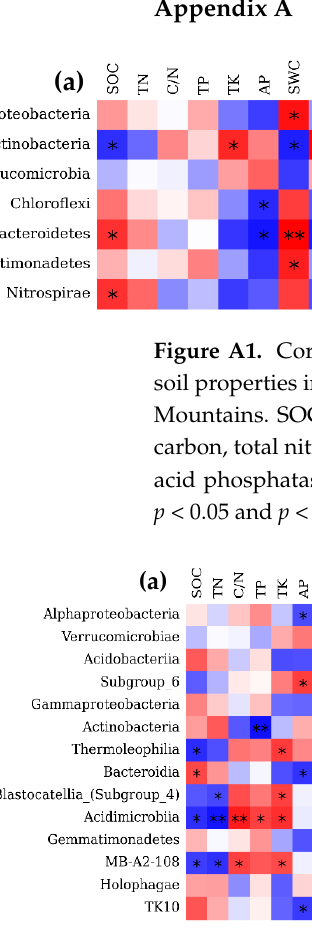
Figure A2. Correlation analysis between bacterial ( a ) and fungal ( b ) class communities and soil properties in broad-leaved Korean pine forest at different succession stages in Lesser Hinggan Mountains. SOC, TN, TP, TK, AP, SWC, Pho, Ure, Suc represents the abbreviations of soil organic carbon, total nitrogen, total phosphorus, total potassium, available phosphorus, soil water content, acid phosphatase, urease, sucrase, respectively. “*” and “**” indicate a significant correlation at p < 0.05 and p < 0.01,